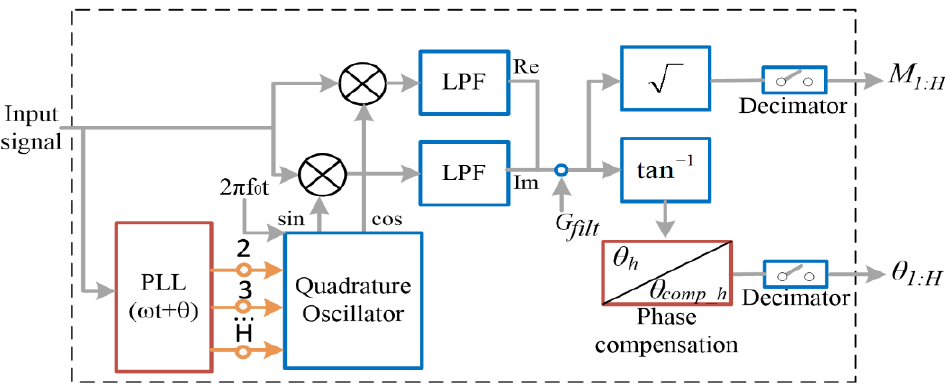
Figure 2. Extended phasor measurement unit (PMU) for fundamental and harmonic phasors.